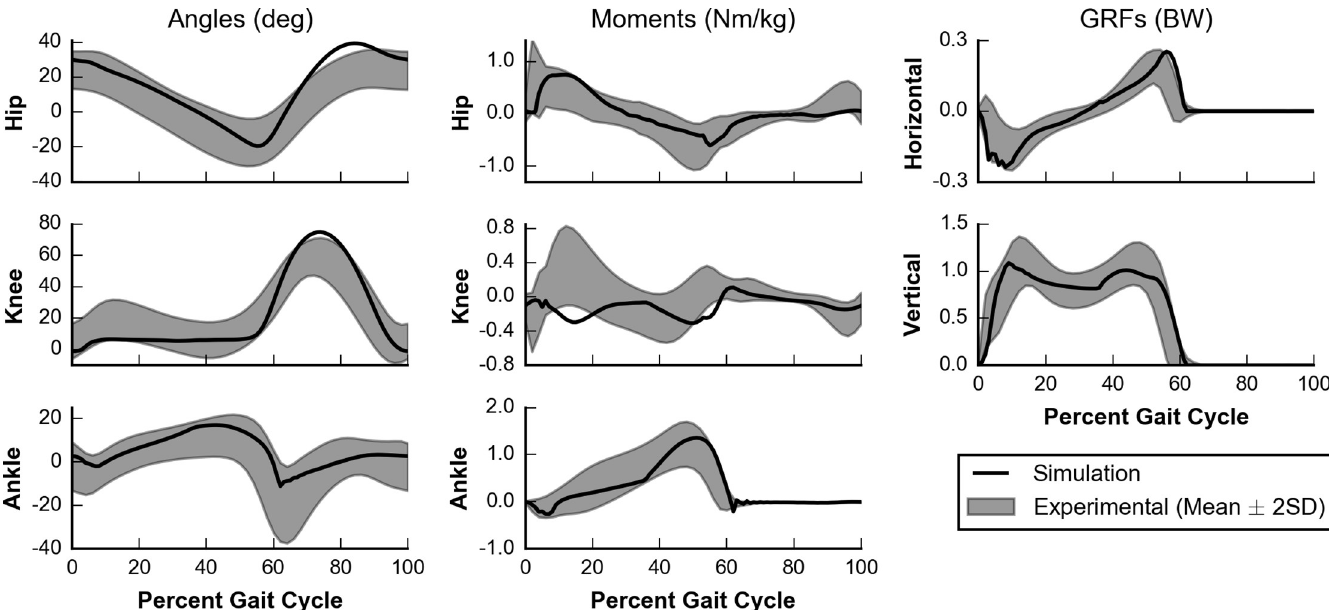
Fig 6. Kinematics and kinetics of gait at self-selected speed. Simulated (black line) kinematics and kinetics are compared to experimental data (gray area) collected by Schwartz et al. [58]. Joint angles (left column) and joint moments (middle column) are plotted for the hip (top row), knee (middle row), and ankle (bottom row). Ground reaction forces (right column) are shown for both horizontal (top row) and vertical (middle row) directions. Positive angles indicate flexion, and positive moments indicate extension. Note that the experimental data for hip flexion angle was shifted by 11.6˚ to account for the difference in pelvis orientation definitions between the experimental data set and the musculoskeletal model.